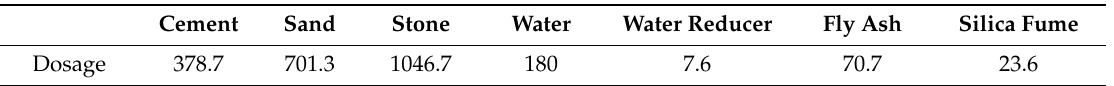
Table 1. Concrete mixture proportion (kg/m 3 ).